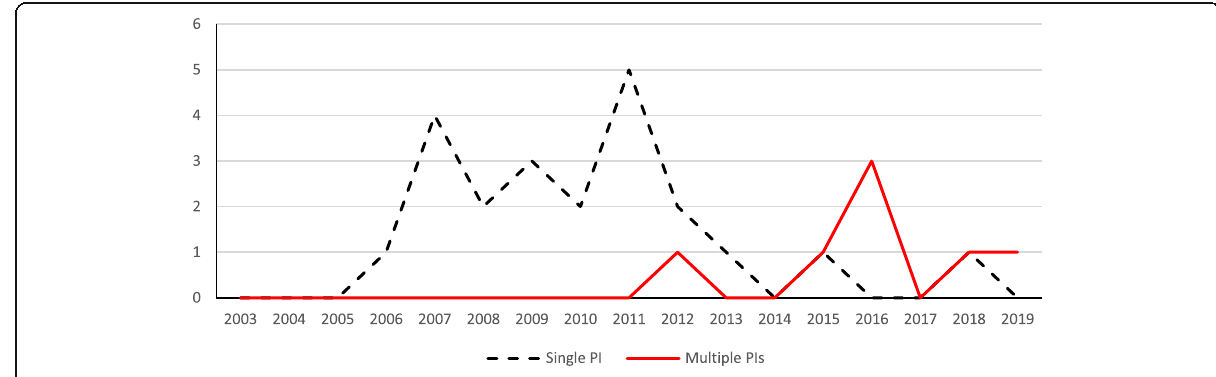
Fig. 10 The distribution of projects with single versus multiple PIs over the years (in “ Special Education Research ”